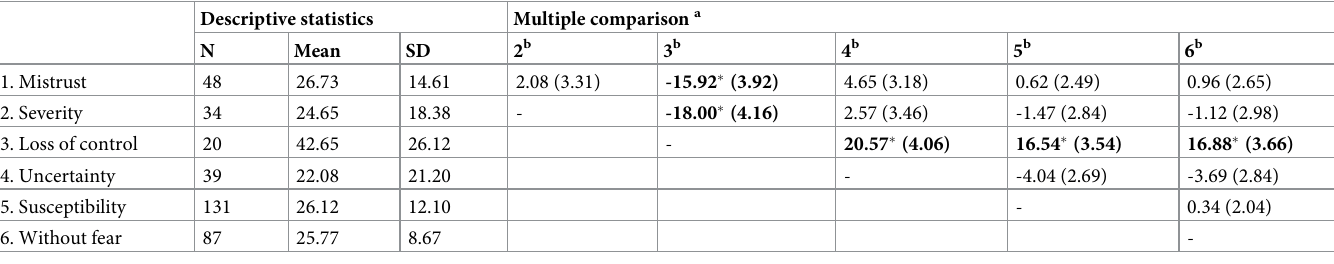
the Third stage, relative to the without fear group. Table 3. Post hoc Scheffe´ test with the bootstrap